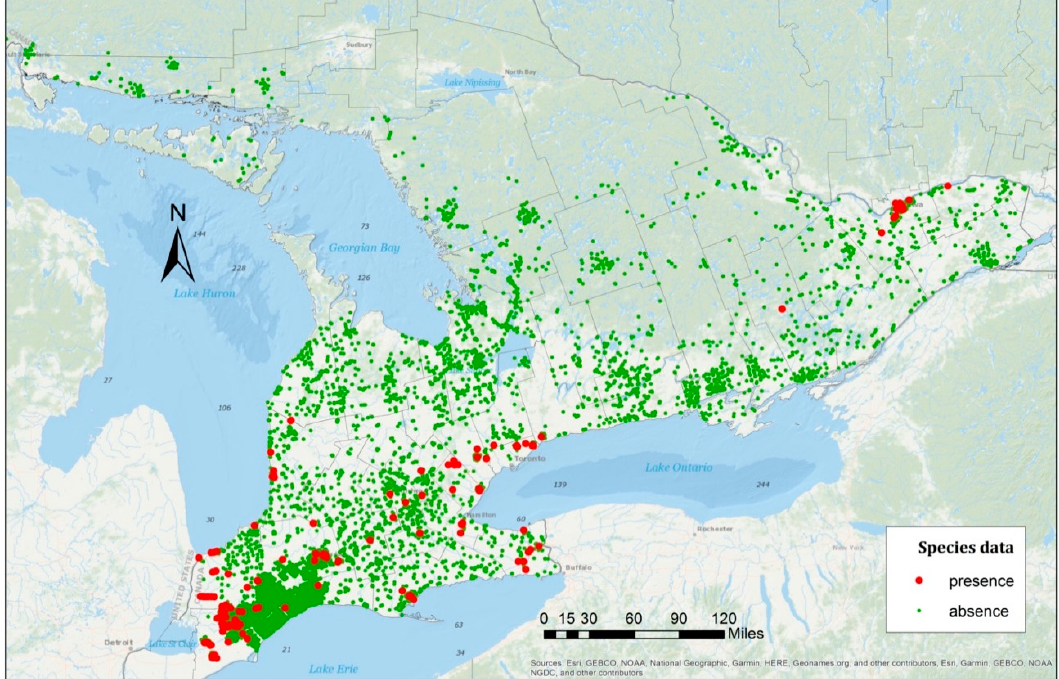
Figure 1. The Emerald Ash Borer (EAB) distribution in Southern Ontario, Canada from 2006 to 2012. Green points are the EAB absence points and red points are the EAB presence points.